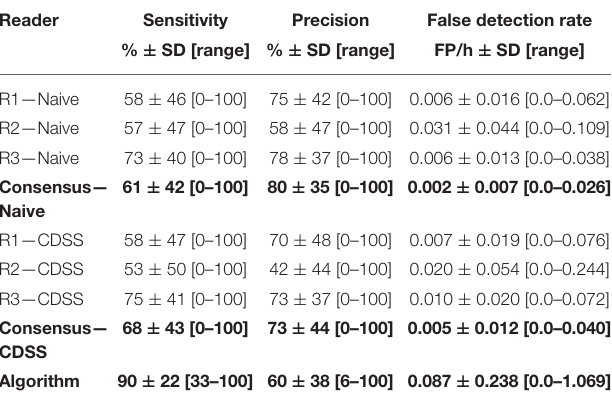
Naïve results are for epileptologist review without algorithm detection support. CDSS results are for epileptologist review with algorithm detection support. Algorithm results are for the REMI automated seizure detection algorithm (SD, standard deviation; FP, false positive).